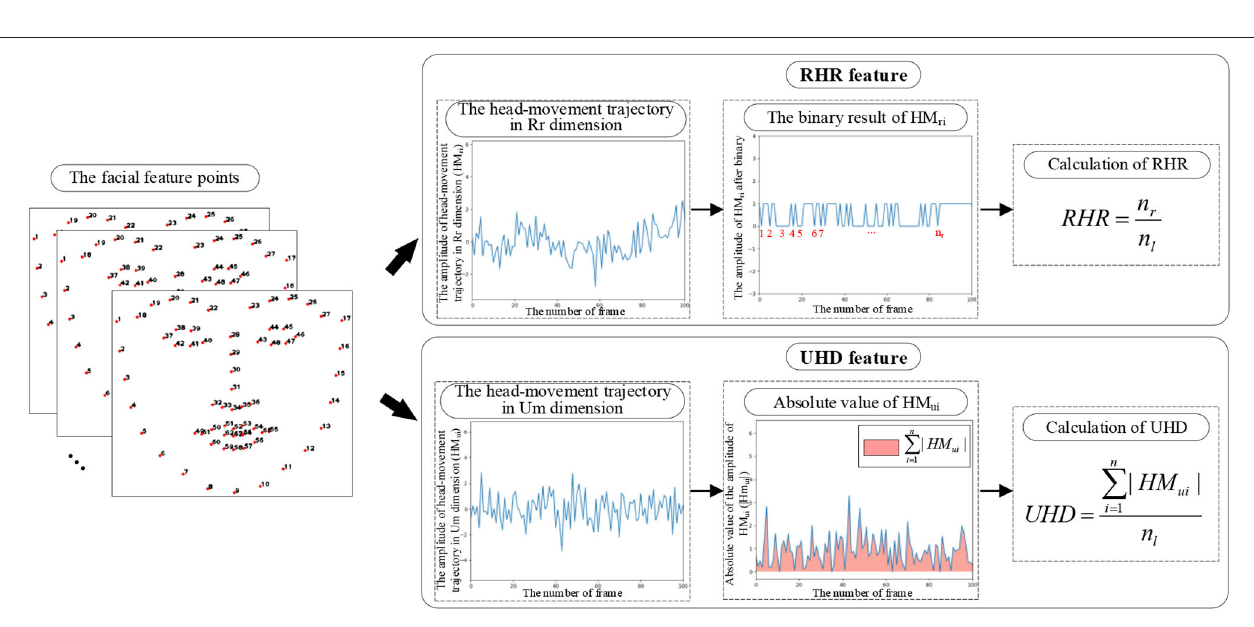
FIGURE 4 | Calculation of the head-movement related